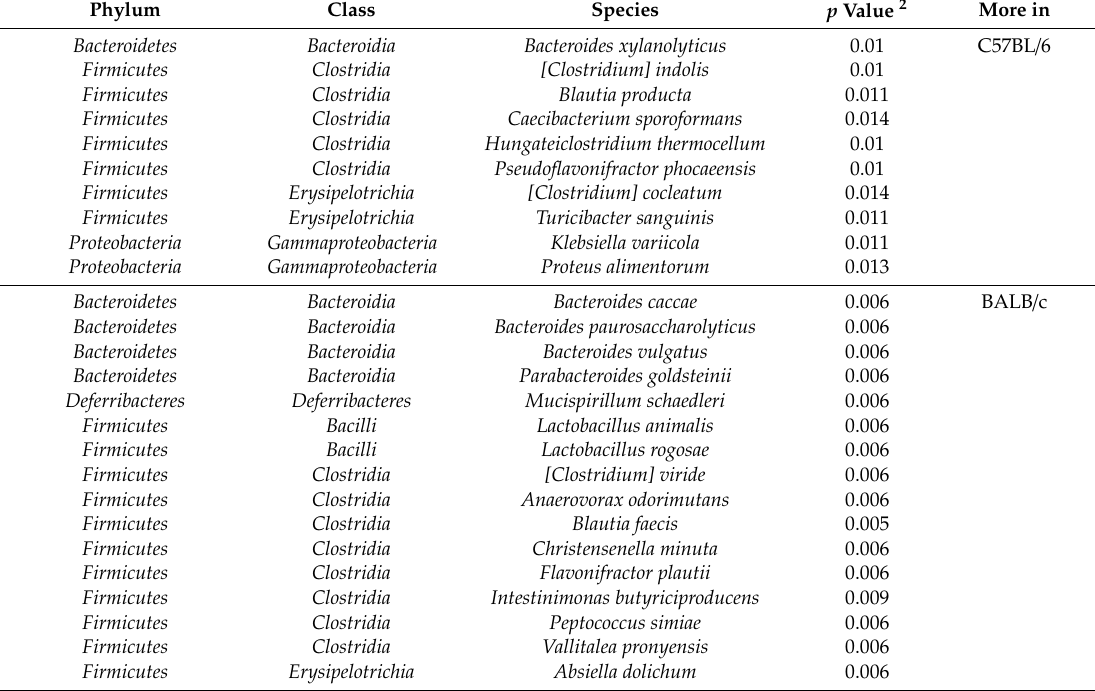
Table 3. Bacterial species with significantly varied abundance between C57BL / 6 and BALB / c mice treated with Tim3VdIg 1